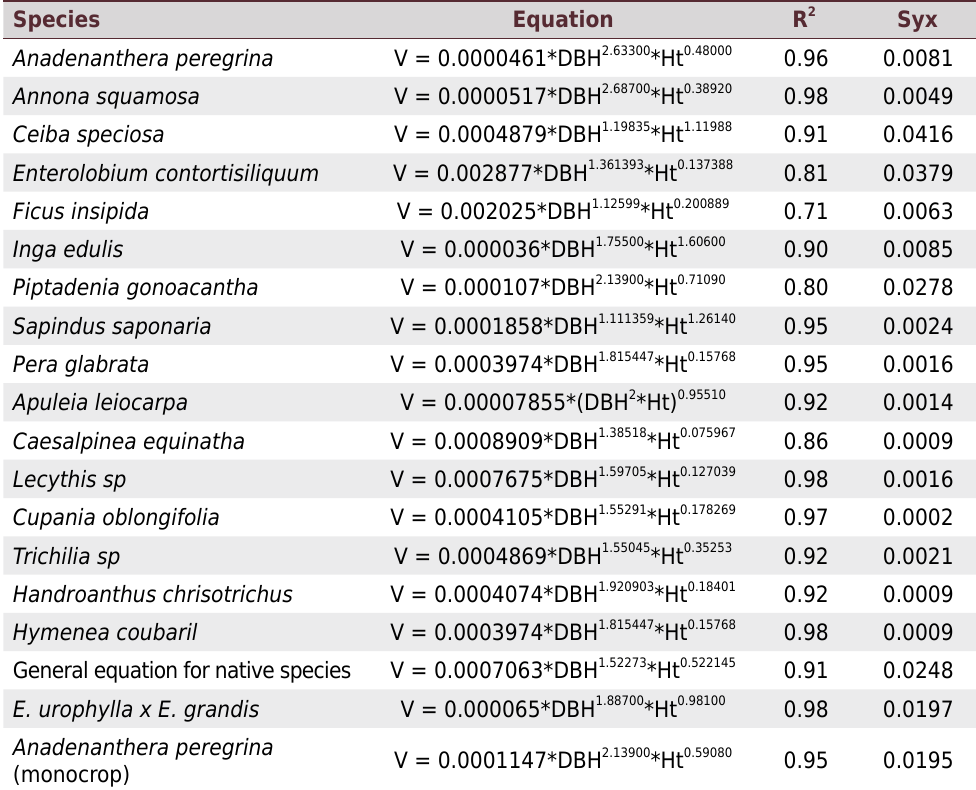
Table 1. Estimation equations for trunk volume with bark (V) (m 3 ) in Eucalyptus (Euc), A. peregrina (Ap), and the 16 native forest species at 56 months of age, planted in an area of bauxite mining